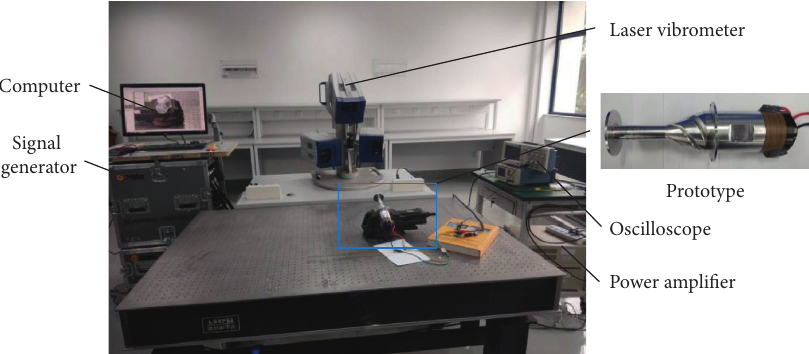
Figure 15: The amplitude experiment platform.